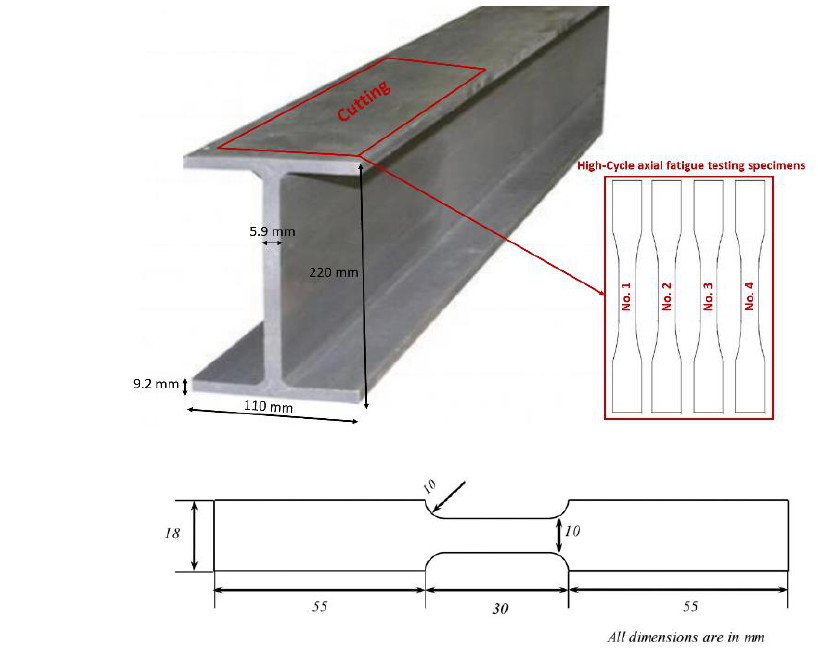
Figure 3. Fabrication of HCF test specimens: ( a ) schematic of the preparation location of the samples from IPE-220 steel pile and ( b ) sample geometry and dimensions.